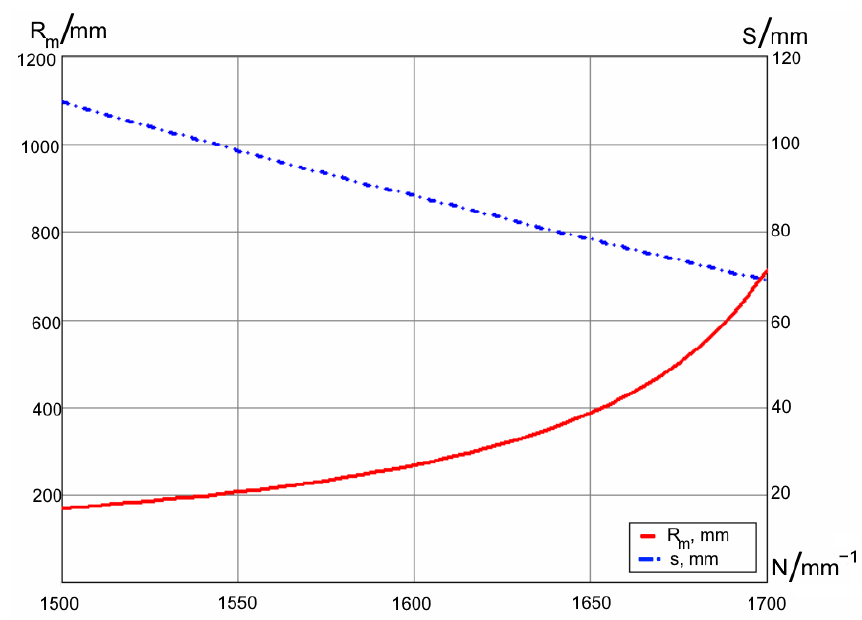
Figure 2. Equivalent pupil shift and the field curvature as a function of the grooves frequency. The plot shows that the ray’s intersection position and the curvature changes signif- icantly with the dispersion. This effect must be taken into account in the spectrograph optical